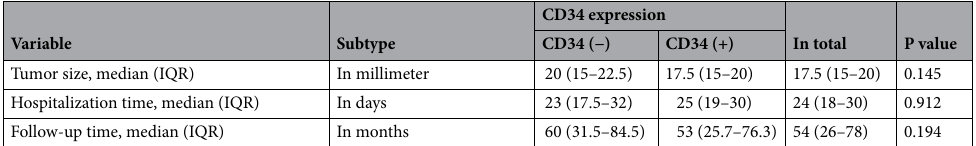
Univariate and multivariate analyses. Clinical and pathological factors in 247 patients were compared between two groups [tumor with CD34 (+) vs. CD34 (−)] (Table 1). Significant differences were found in tumor types (GG vs. DNT, P < 0.001), patient population (children vs. adults, P = 0.015), seizure aura (P = 0.007), drug- resistant epilepsy (P = 0.036), concordance of ictal EEG findings (concordant vs. discordant, P = 0.032), surgical resection extent (simple tumor resection vs. extensive tumor resection, P = 0.045), tumor location (temporal vs. non-temporal, P = 0.007) and duration of epilepsy (P = 0.027). In particular, surgical outcomes of seizure control (P = 0.807) and tumor recurrence (P = 0.474) were not found with differences between two groups. Multivari- ate binary logistic regression analysis finally included the tumor type (GG vs. DNT, P < 0.001; OR 13.3, 95% CI 5.9–29.9) and the patient population (adults vs. children, P = 0.014; OR = 2.5, 95% CI 1.2–5.2) into the predicting model of GNT with CD34 positive expression. The clinical and pathological features of 102 patients who had IHC detection of BRAF V600E mutation were also compared between two groups [tumor with BRAF (+) vs. BRAF (−)] (Table 2). Significant differences were found in concordance of ictal EEG findings (concordant vs. discordant, P = 0.031) and age at surgery (P = 0.015), but not in surgical outcomes of seizure control (P = 0.937) and tumor recurrence (P = 1.000). Finally, only the age at surgery (P = 0.019, OR 1.05, 95% CI 1.01–1.10) was found with significance in multivariate binary logistic regression model.